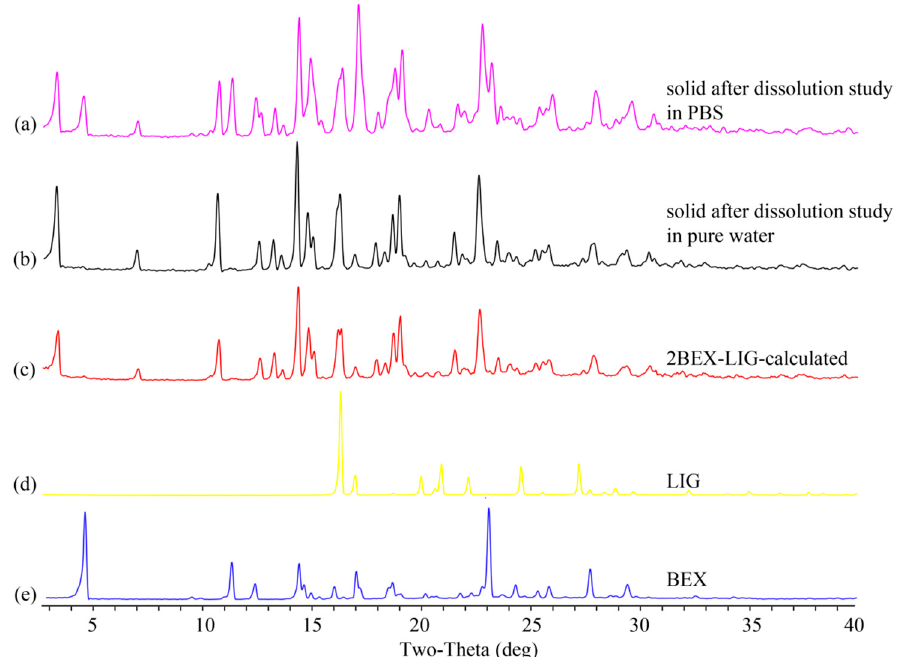
Figure 7. Powder X-ray diffraction (PXRD) patterns of the samples: ( a ) sample after dissolution study in phosphate buffer saline (PBS); ( b ) solid after dissolution study in pure water; ( c ) calculated 2bexarotene-ligustrazine (2BEX-LIG); ( d ) ligustrazine (LIG); and ( e ) bexarotene (BEX).